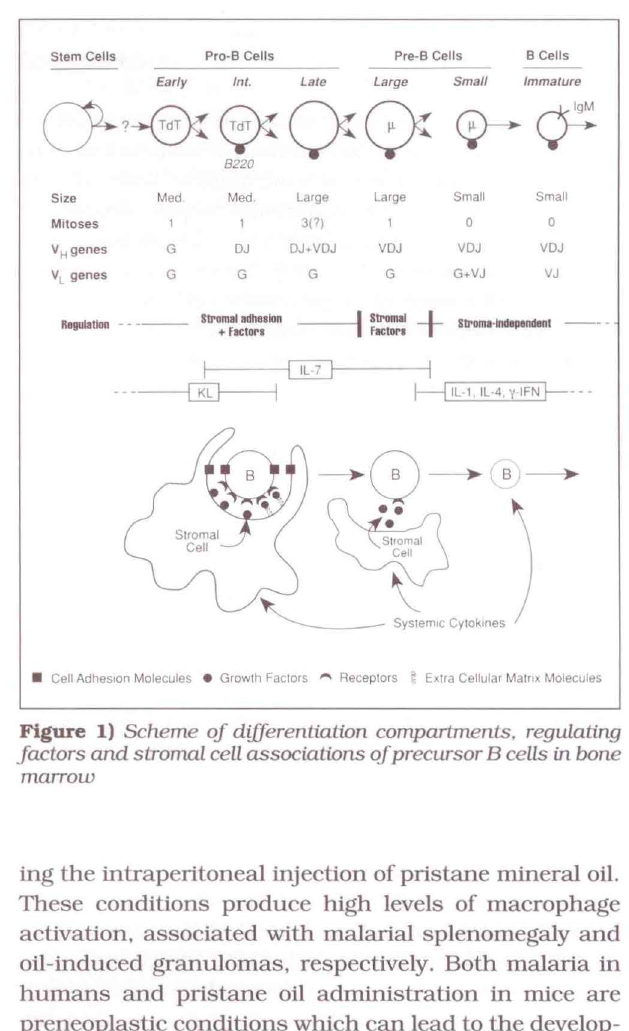
ing the intraperitoneal injection of pristane mineral